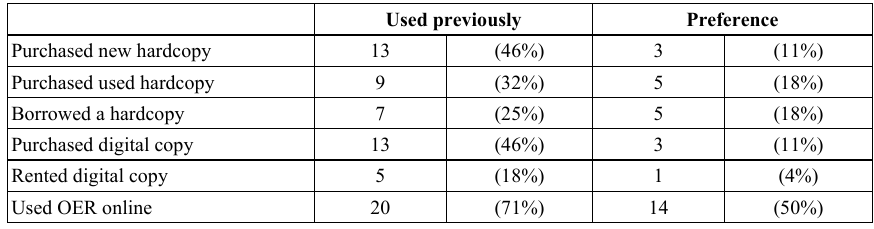
Fig. 2. Independent variables responses Table 2. Type of textbook use and preference